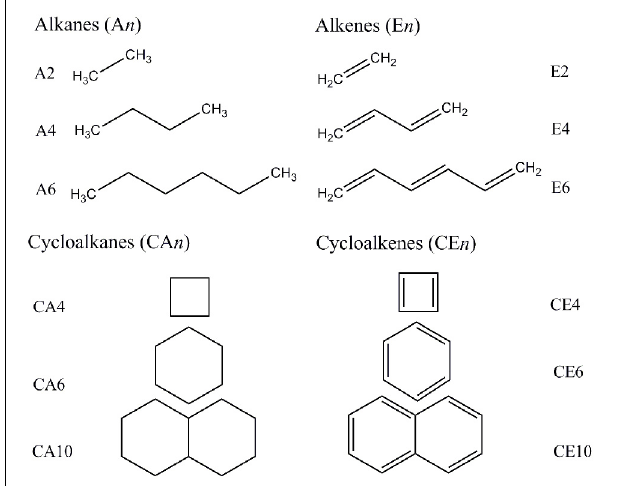
FIGURE 3 | Acylic and acylic hydrocarbons considered in this study.